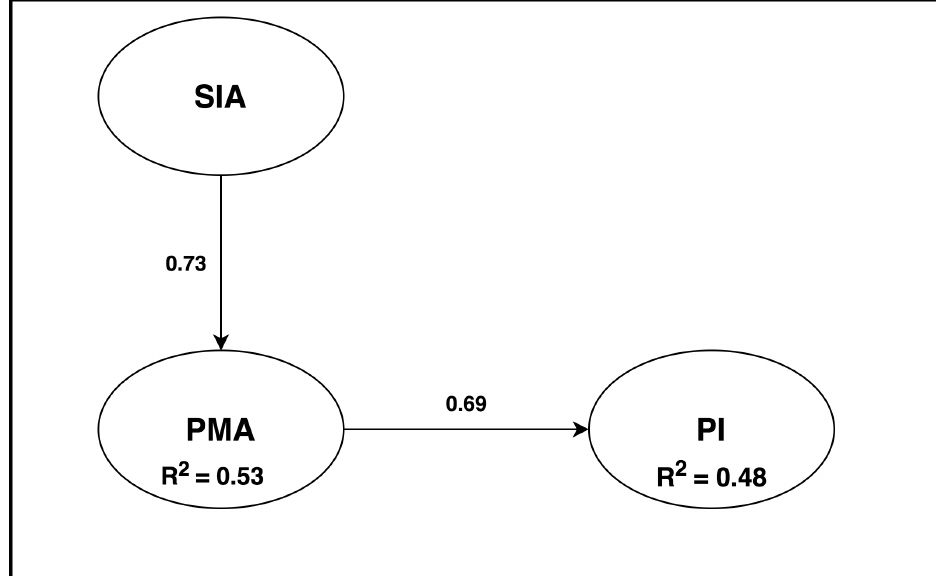
Figure 4. The results of the direct structural model between PMA and PI: standardized path coeffi- cient